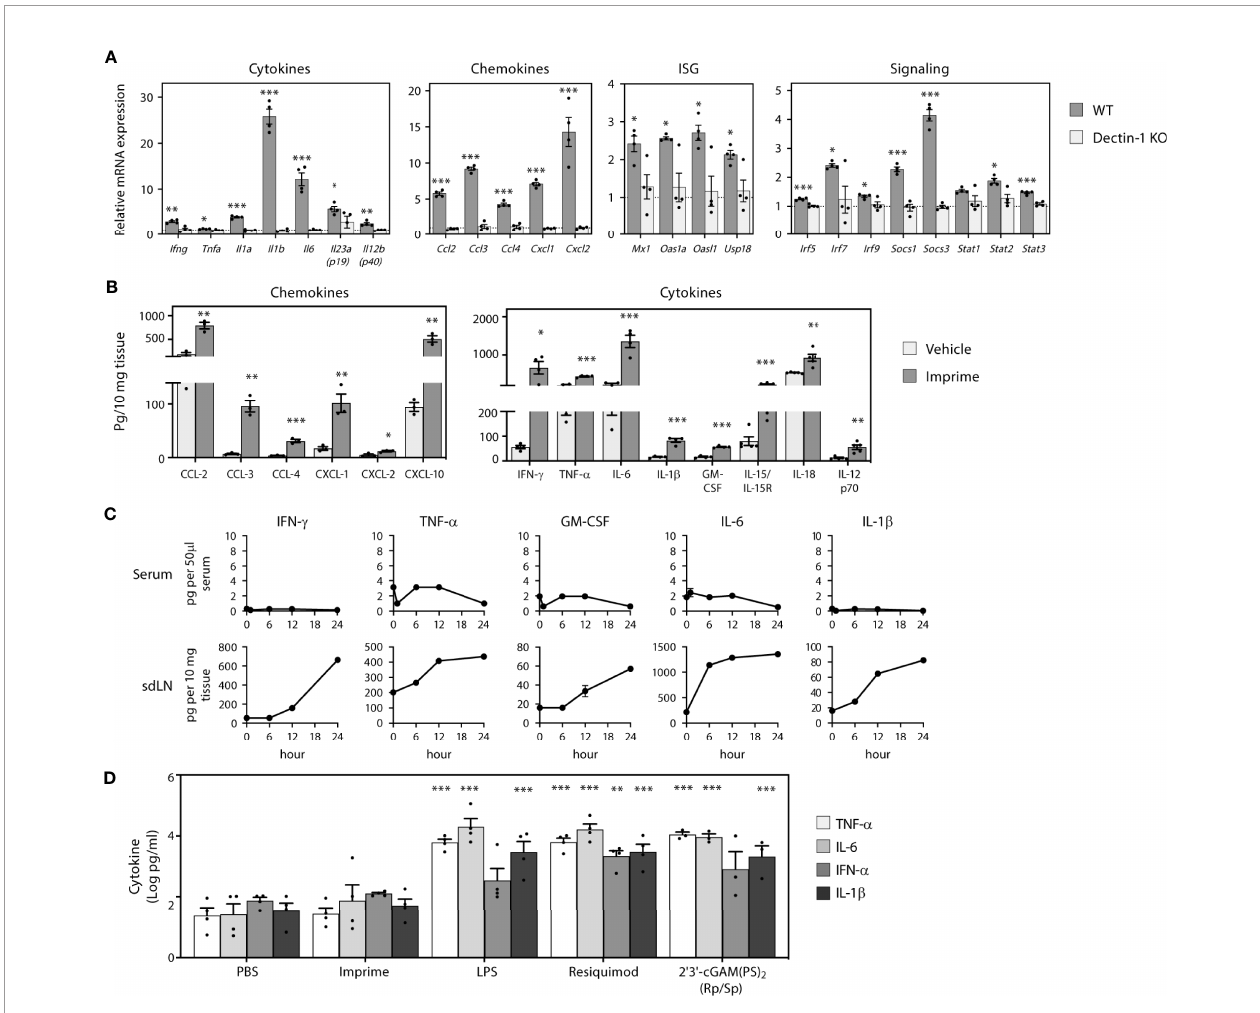
FIGURE 1 | Imprime induces production of cytokines, chemokines, and type I IFNs. Naïve WT or Dectin-1 KO C57BL/6 mice (n = 3-5) were injected i.v. with PBS or 1.2 mg Imprime. (A) Transcriptional changes of cytokines, chemokines, ISG and signaling in sdLNs evaluated at 16 hours using a custom QuantiGene Plex and (B) chemokine and cytokine proteins were evaluated using the Luminex platform at 24 hours. (C) Time course of cytokine production was analyzed in serum and sdLNs. Representative results from ≥ 2 experiments are shown. (D) Human whole blood was treated with Imprime, TLR-4 agonist LPS, TLR-7/8 agonist Resiquimod, STING agonist 2 ’ 3 ’ -cGAM(PS) 2 (Rp/Sp) (all at 10 m g/ml), or PBS. Plasma was collected after 24 hours, and cytokines were analyzed by the Luminex platform. Log- transformed cytokine levels for 3 donors were compared. All summary data are presented as mean ± SEM. Multiple t tests with Holm-Sidak ’ s multiple comparison were used for (A, B) . Two-way ANOVA with Holm-Sidak ’ s multiple comparison was used in (D) . * p < 0.05, ** p < 0.01, *** p <